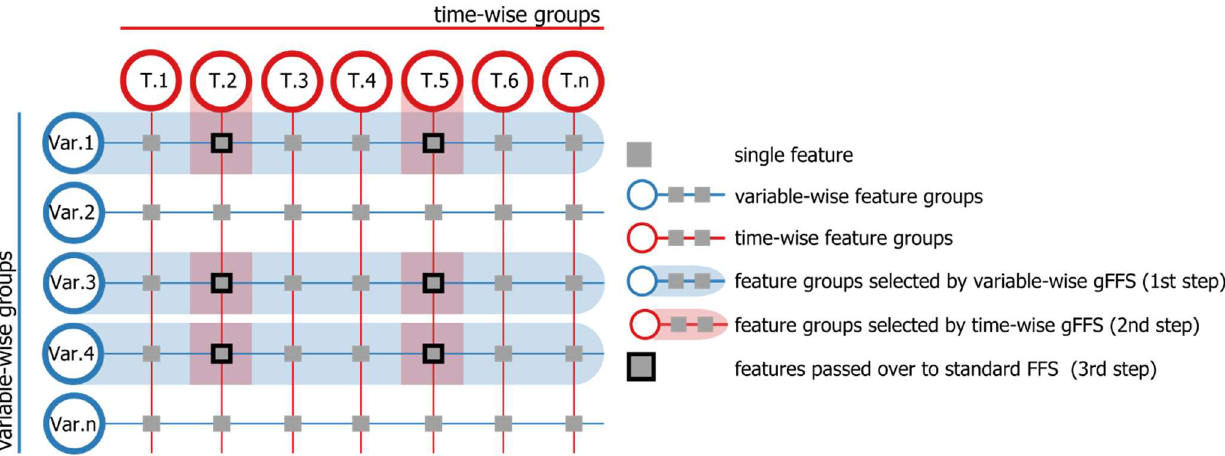
Figure 5. 3-step group-wise Forward Feature Selection (gFFS)